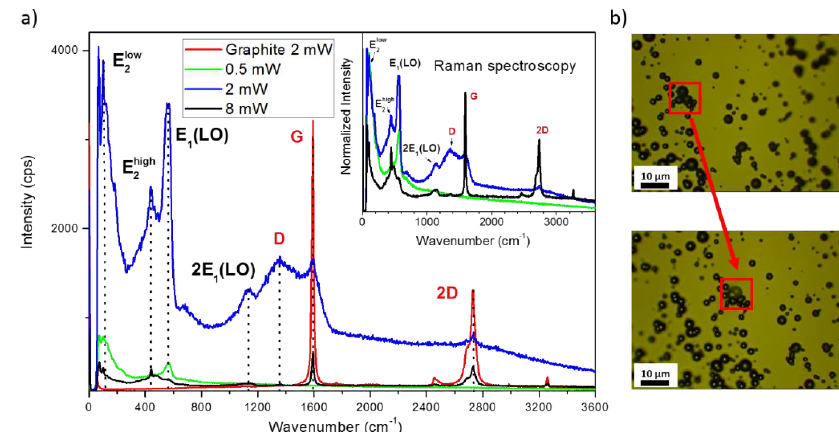
Figure 9. ( a ) Averaged Raman spectra sample of as grown ZnO/HOPG at different laser powers. Red spectrum depicts clean HOPG of this sample; ( b ) optical images of the mapped area before (top) and after (bottom) high laser power (8 mW) exposure.